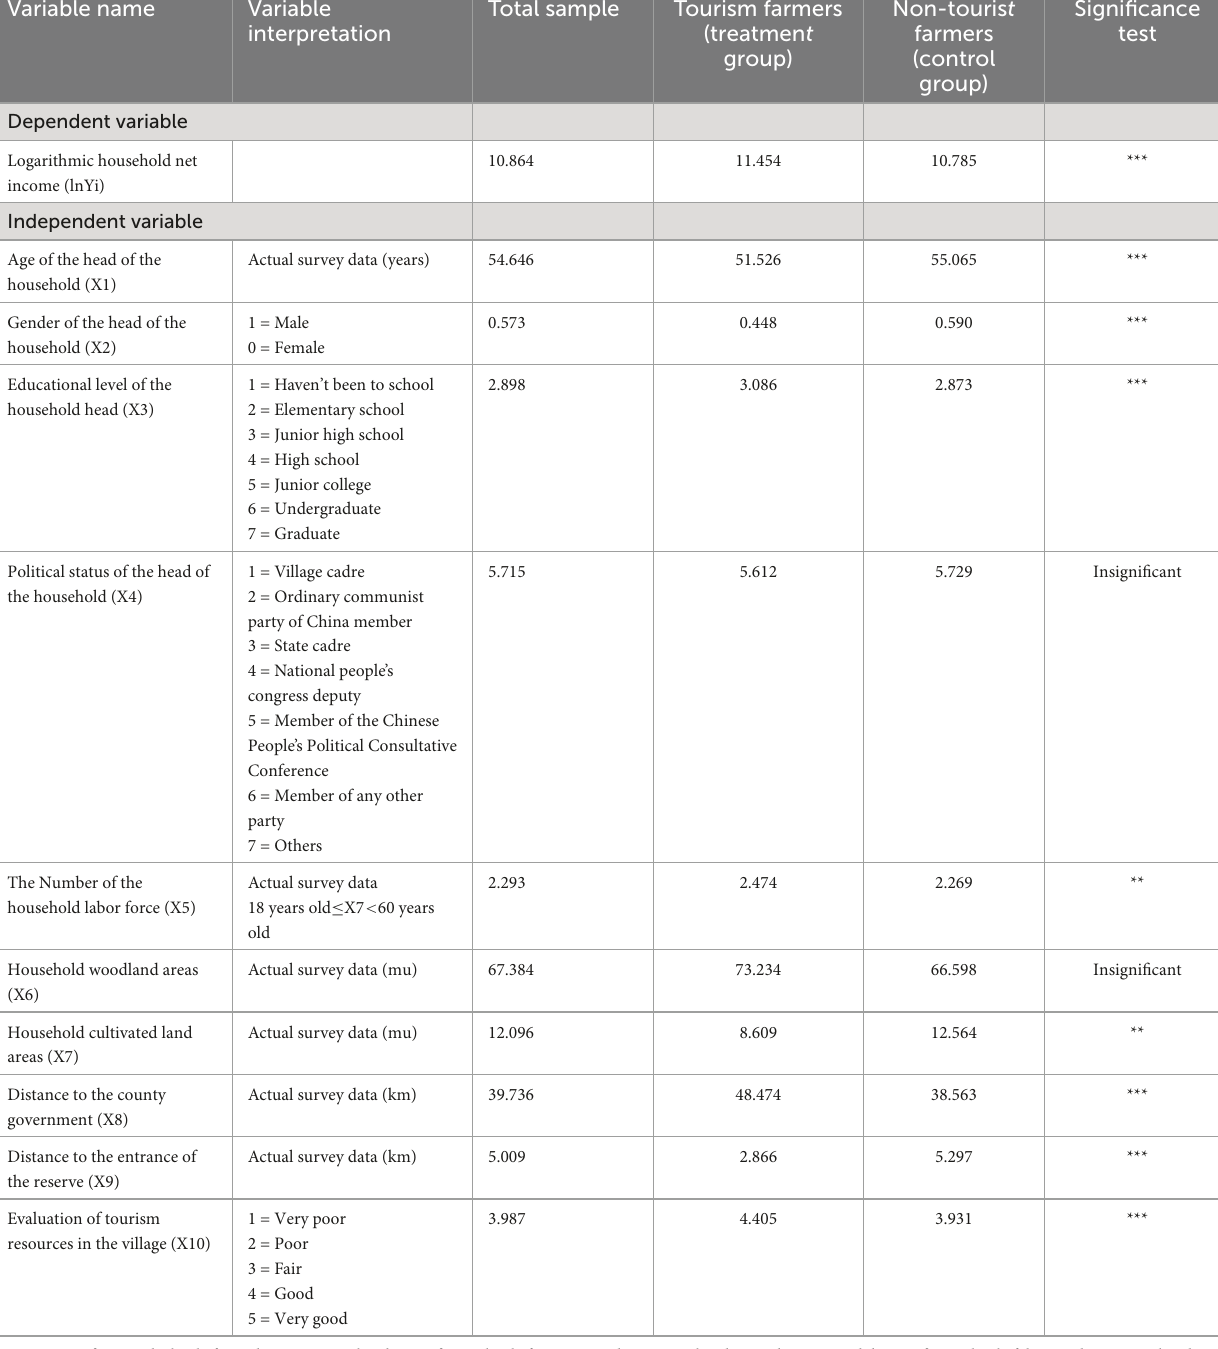
TABLE 1 Main explanatory variables and descriptive